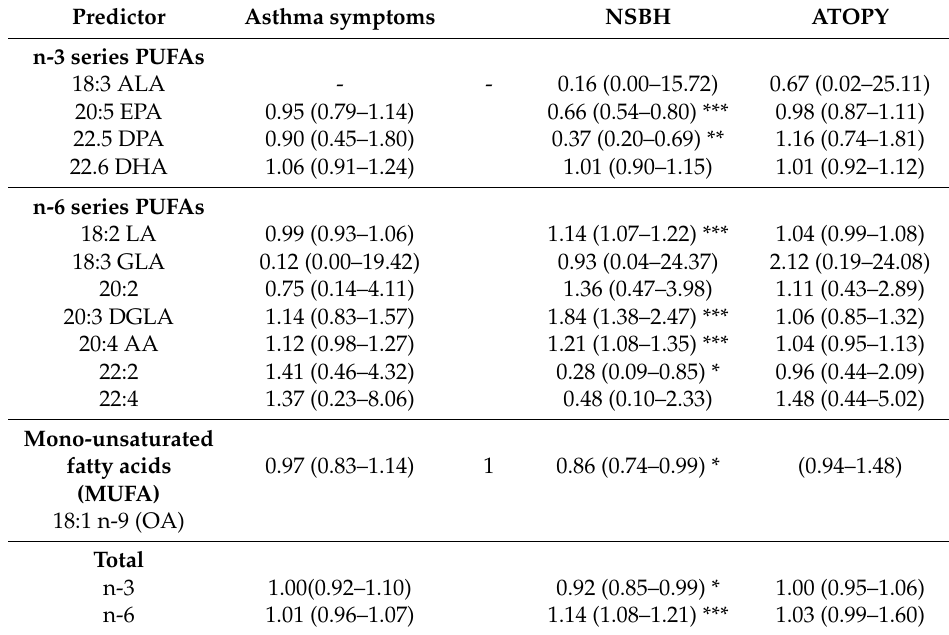
Table 6. Multivariate logistic regression models for asthma endpoints in relation to serum phospholipid (% weight) among fishing village inhabitants along the West Coast of South